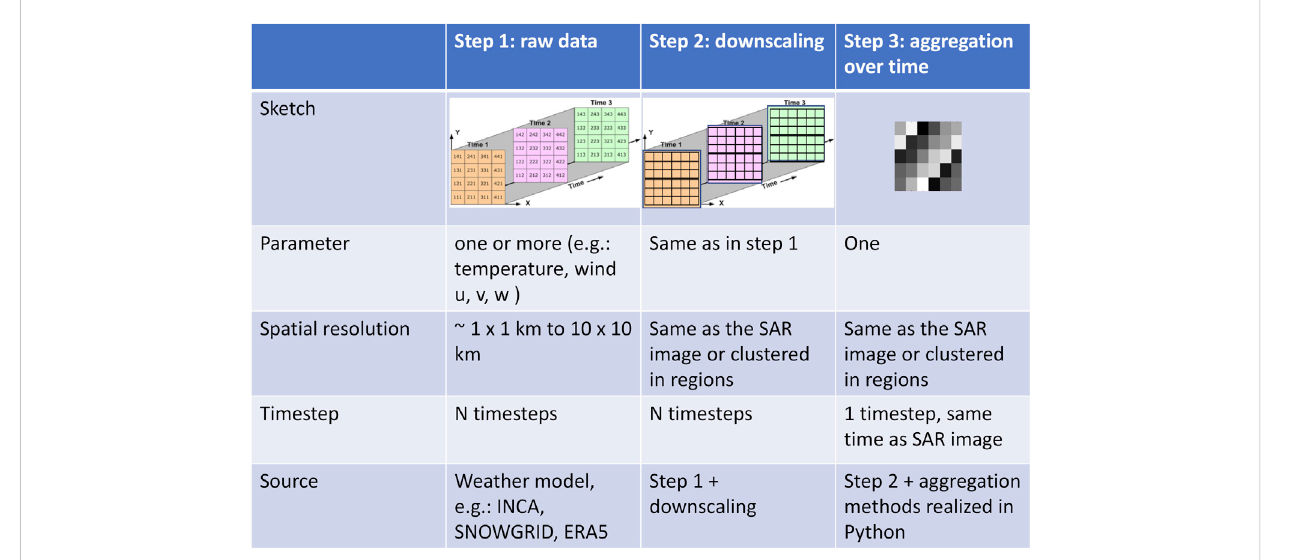
FIGURE 6 Overview of the steps to encode weather history for the use in the segmentation